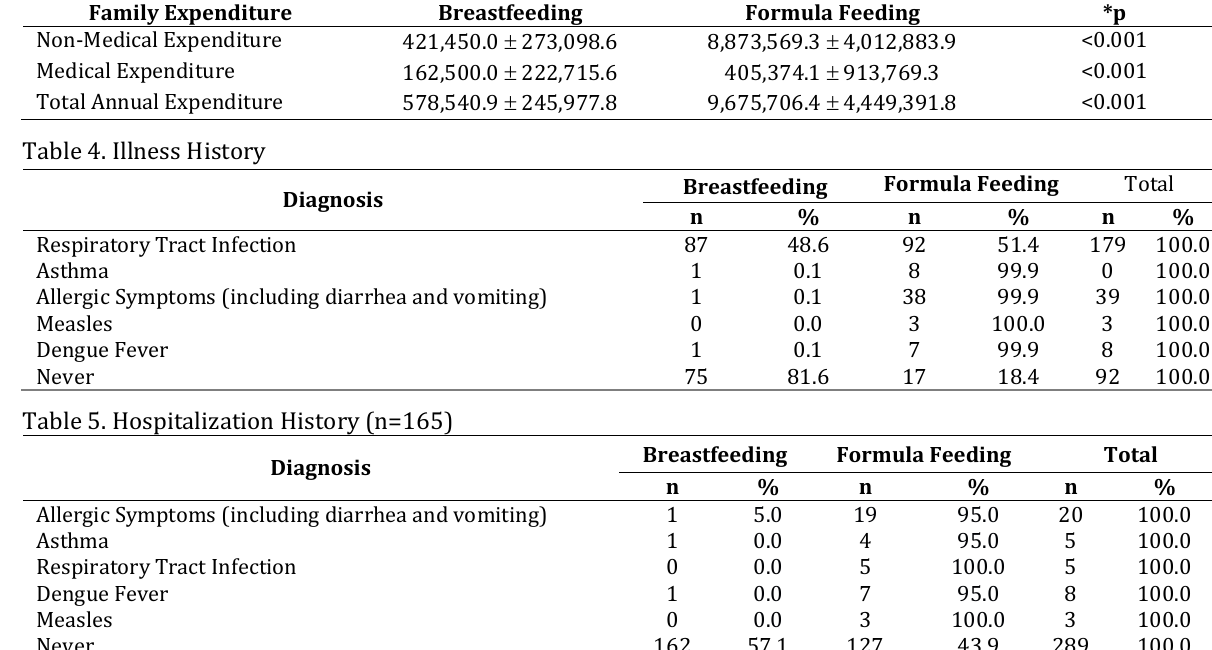
Table 3. Comparison of Average Family Losses based on Accumulated Non-Medical Economic Impacts (in Indonesian Rupiah)